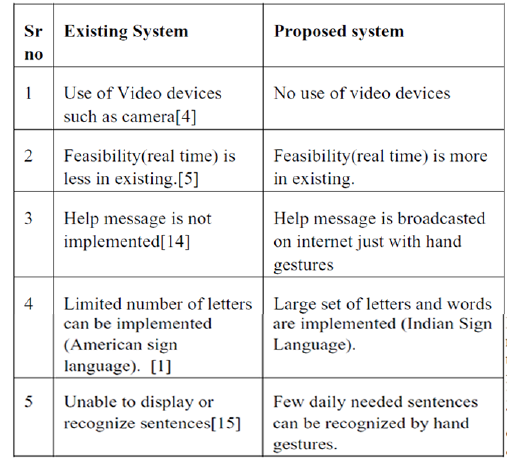
Table 1. Summary of Existing